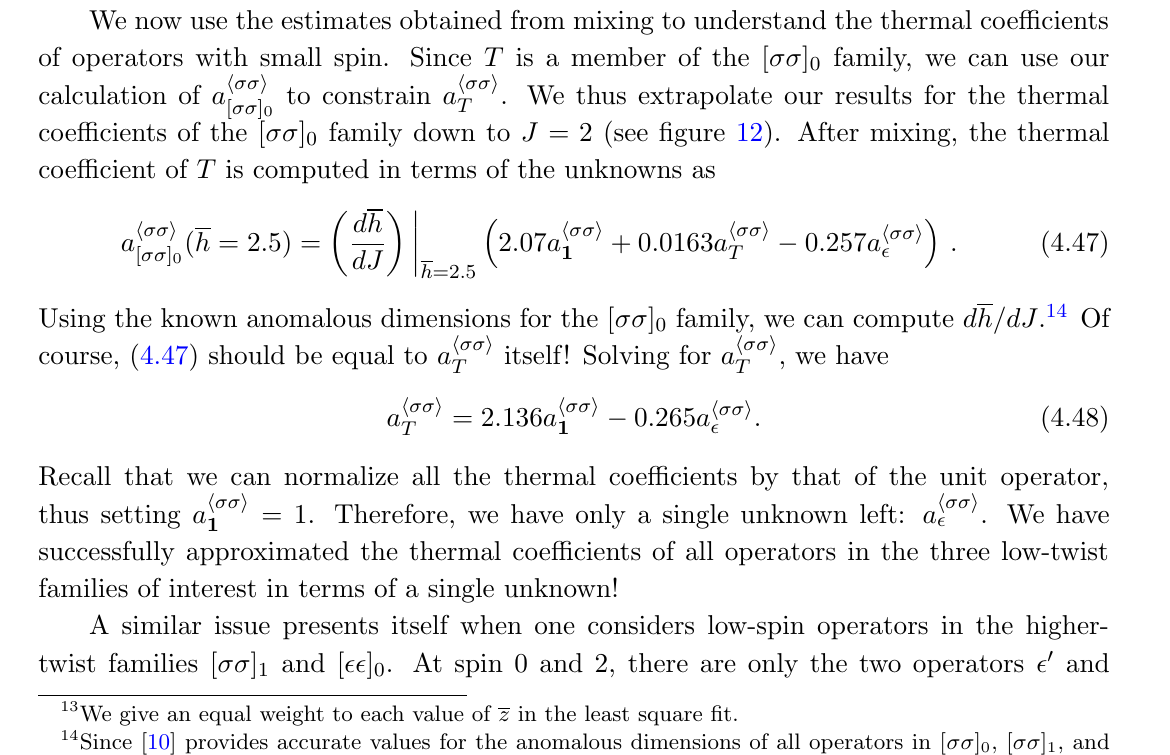
for each value of h . 13 To exemplify our procedure, in (cid:12)gure 11, we show how the